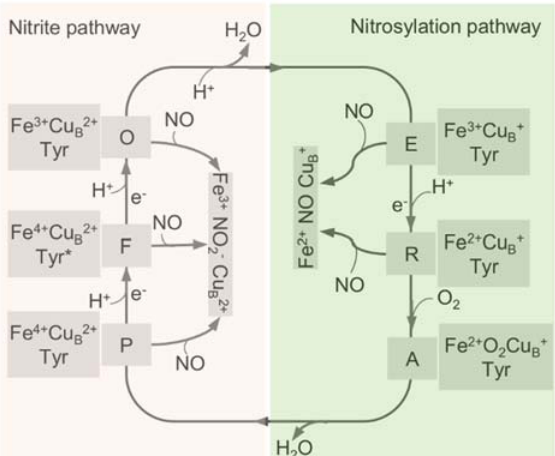
Figure 3. The catalytic cycle of HCO and the interplay with NO through the two pathways. The catalytic cycle of HCO is schematically reported with the indication of the redox and the oxygen ligation state of the BNC (heme a3-CuB active site). In the reductive phase, the oxidized species O is fully reduced to R by two single-electron donations via formation of the half-reduced intermediate E. In the oxidative phase, upon reaction with O 2 , R converts to P and F, and O is regenerated eventually through further electron transfer. The nitrite-bound derivative (Fe 3+ CuB 2+ NO 2 − ) and the nitrosylated adduct (Fe 2+ CuB + NO) are generated by the reactions of these intermediates with NO. Tyr, CuB ‐ interacting residue Y244, with an asterisk representing the radical form.